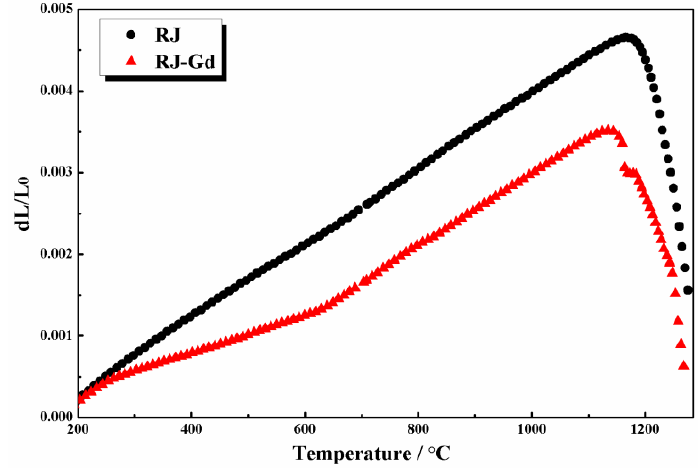
Figure 7. Thermal expansion curves of fluxes.